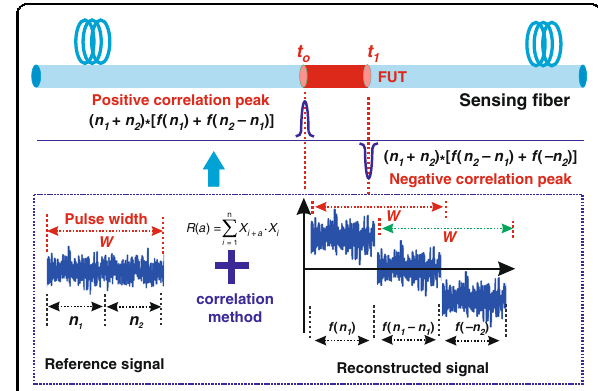
Fig. 9 Schematic diagram and demodulation principle of the compression correlation demodulation